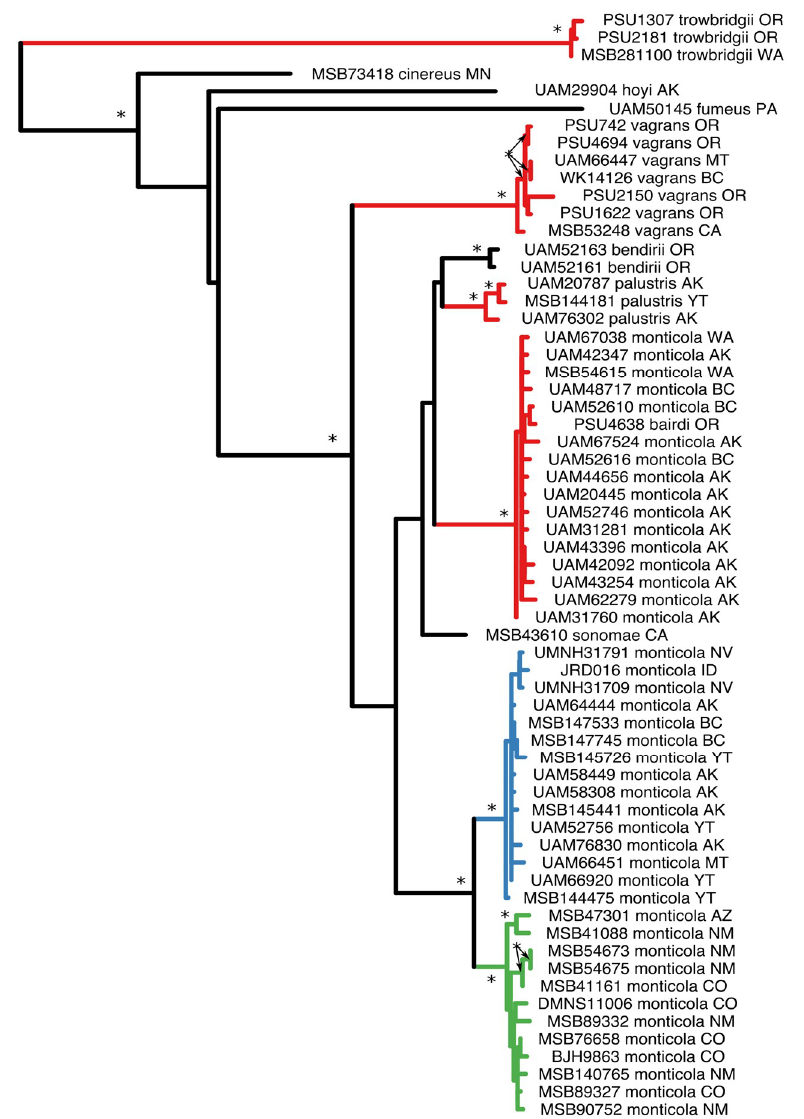
Figure 2. Maximum likelihood phylogeny of the Sorex vagrans complex cytochrome b inferred using RAxML and rooted at the midpoint. Bootstrap support values greater than 70% are indicated with an asterisk. Color-coded branches correspond to geographic clades of the virus: Green = Southern Continental; blue = Northern Continental; red = Pacific Coastal. State abbreviations: AK, Alaska; AZ, Arizona; BC, British Columbia; CA, California; CO, Colorado; ID, Idaho; MN, Minnesota; MT, Montana; NM, New Mexico; NV, Nevada; OR, Oregon; PA, Pennsylvania; WA, Washington; YT,